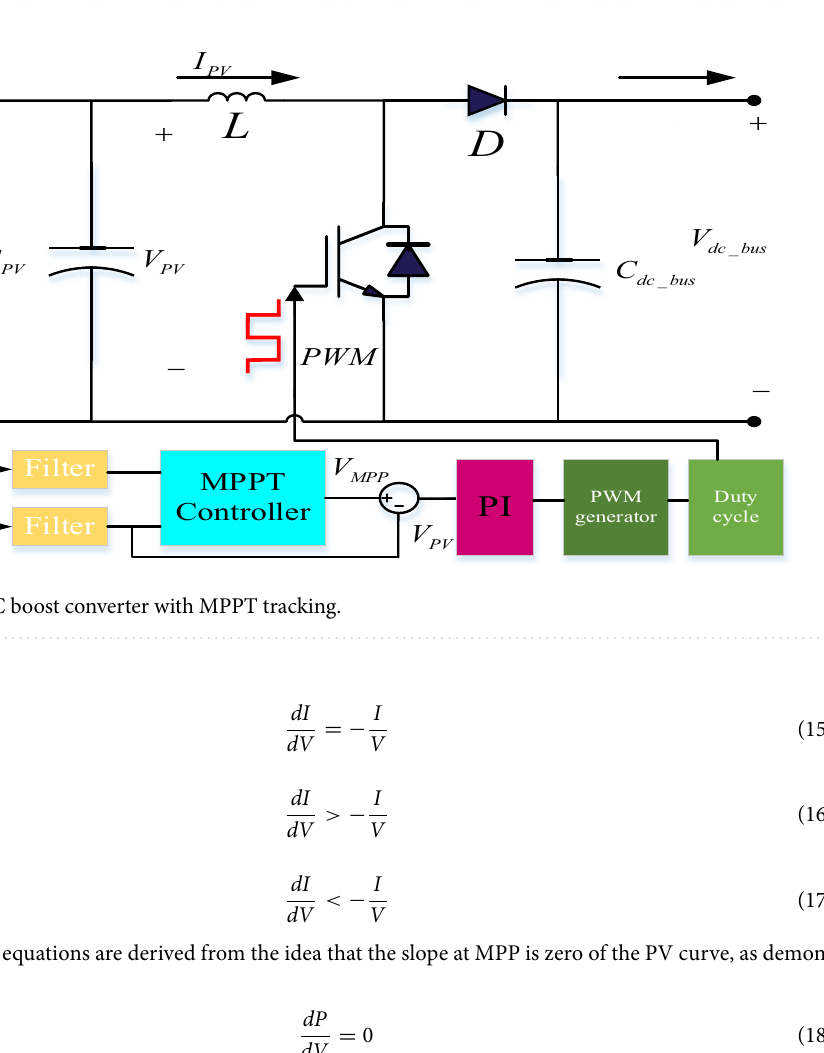
Figure 3. The block diagram of the proposed PV/BES grid-connected system.